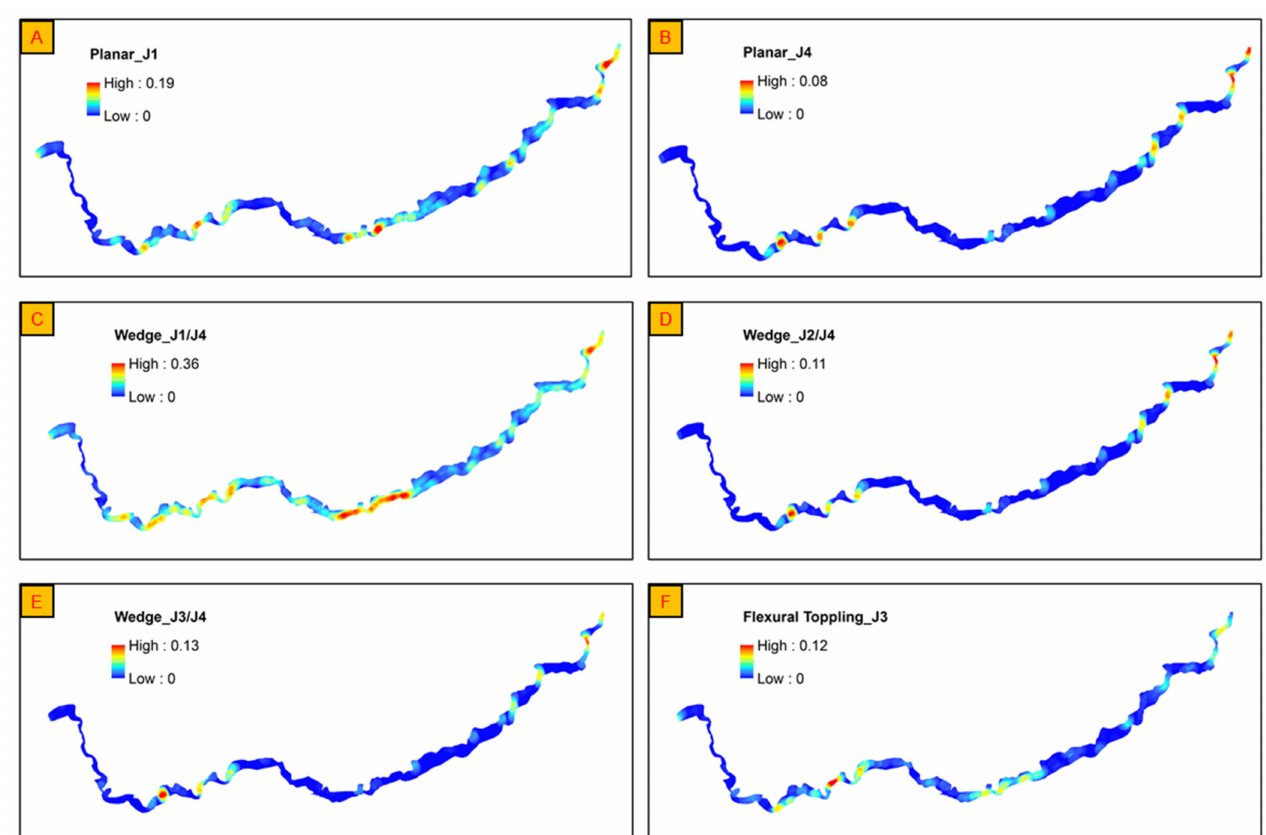
Figure 6. Discontinuity-related factors obtained from GIS-based kinematic analysis, showing the density of pixels prone to kinematic failures, including possible ( A ) planar failures caused by J1, ( B ) planar failures caused J4, ( C ) wedge failures caused by J1/J4, ( D ) wedge failures caused J2/J4, ( E ) wedge failures caused J3/J4, and ( F ) flexural toppling failures caused by